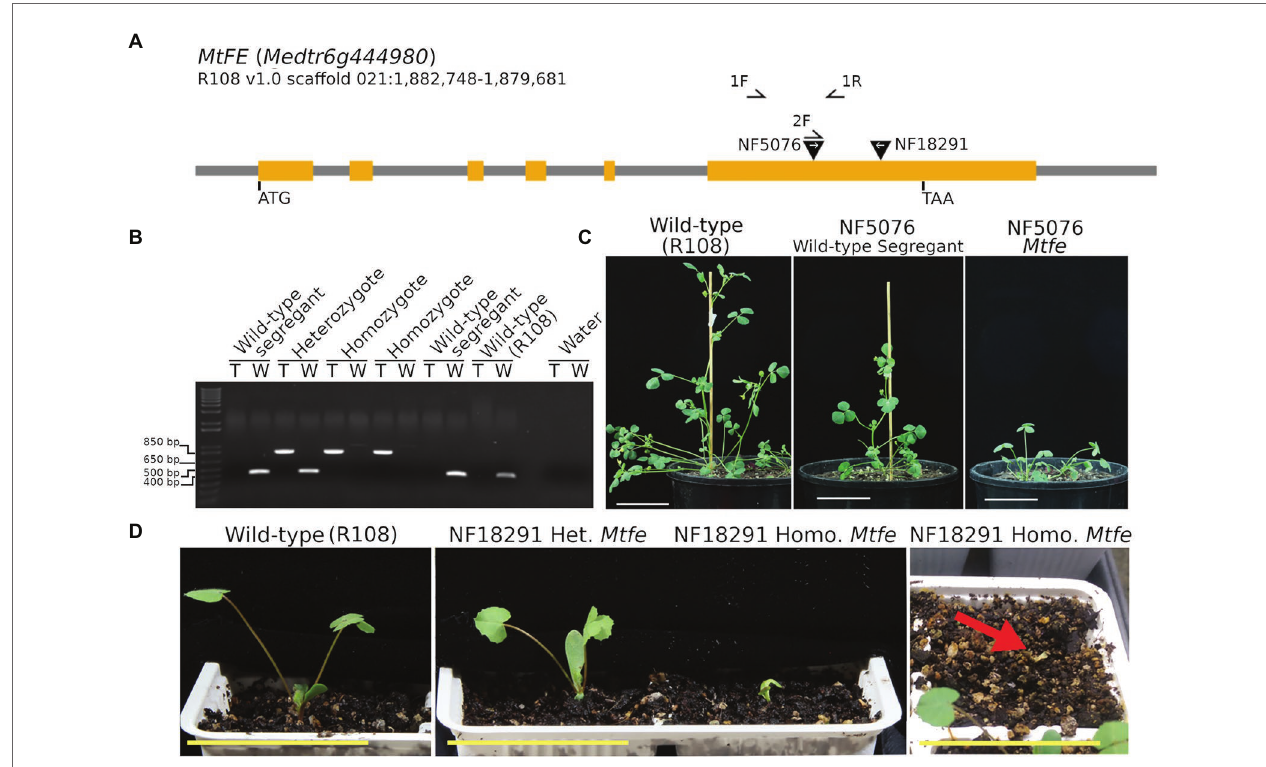
FIGURE 3 | Medicago truncatula MtFE mutant NF5076 has a condensed aerial architecture while NF18291 exhibits seedling lethality. (A) is a schematic of the MtFE locus with the orange rectangles representing the exons and two inverted black triangles the location of the confirmed Tnt1 insertions. The white arrows denote the orientation of the Tnt1 insertion. Primers used are indicated by half arrows. (B) is an example of a genotyping gel for the NF5076 line with two reactions per plant. The first amplifies the Tnt1 insertion allele (T) with primers 2F and 1R (854 bp) and the second amplifies the wild type R108 allele (W) with primers 1F and 1R (416 bp). (C) are photos of 41 days old NF5076 plants which have a condensed architecture phenotype relative to the wild type R108. (D) shows the small seedling growth phenotype of NF18291 Mtfe plants at 10 days old (left and middle panel). The far-right panel shows how at 14 days these plants atrophy and die. All plants were grown in VLD. All scale bars are 5